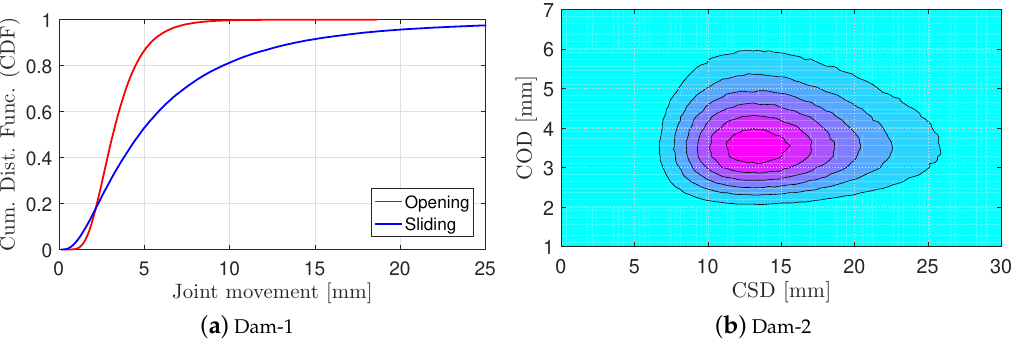
Figure 11. ( a , b ) Uncertainty quantification of joint opening and sliding.